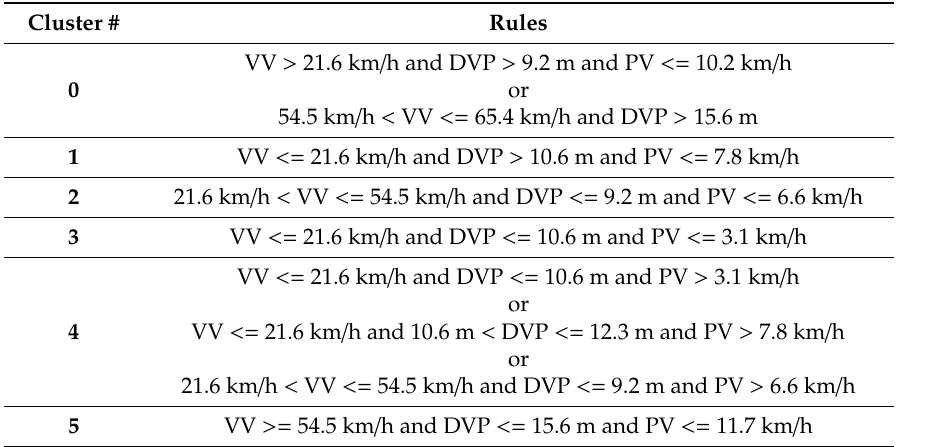
Figure 14. Result of decision tree with pruning. Table 4. Rules derived from decision